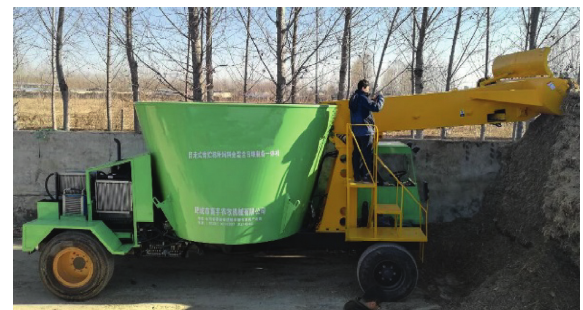
Figure 17: Field test of the prototype of the self-propelled TMR